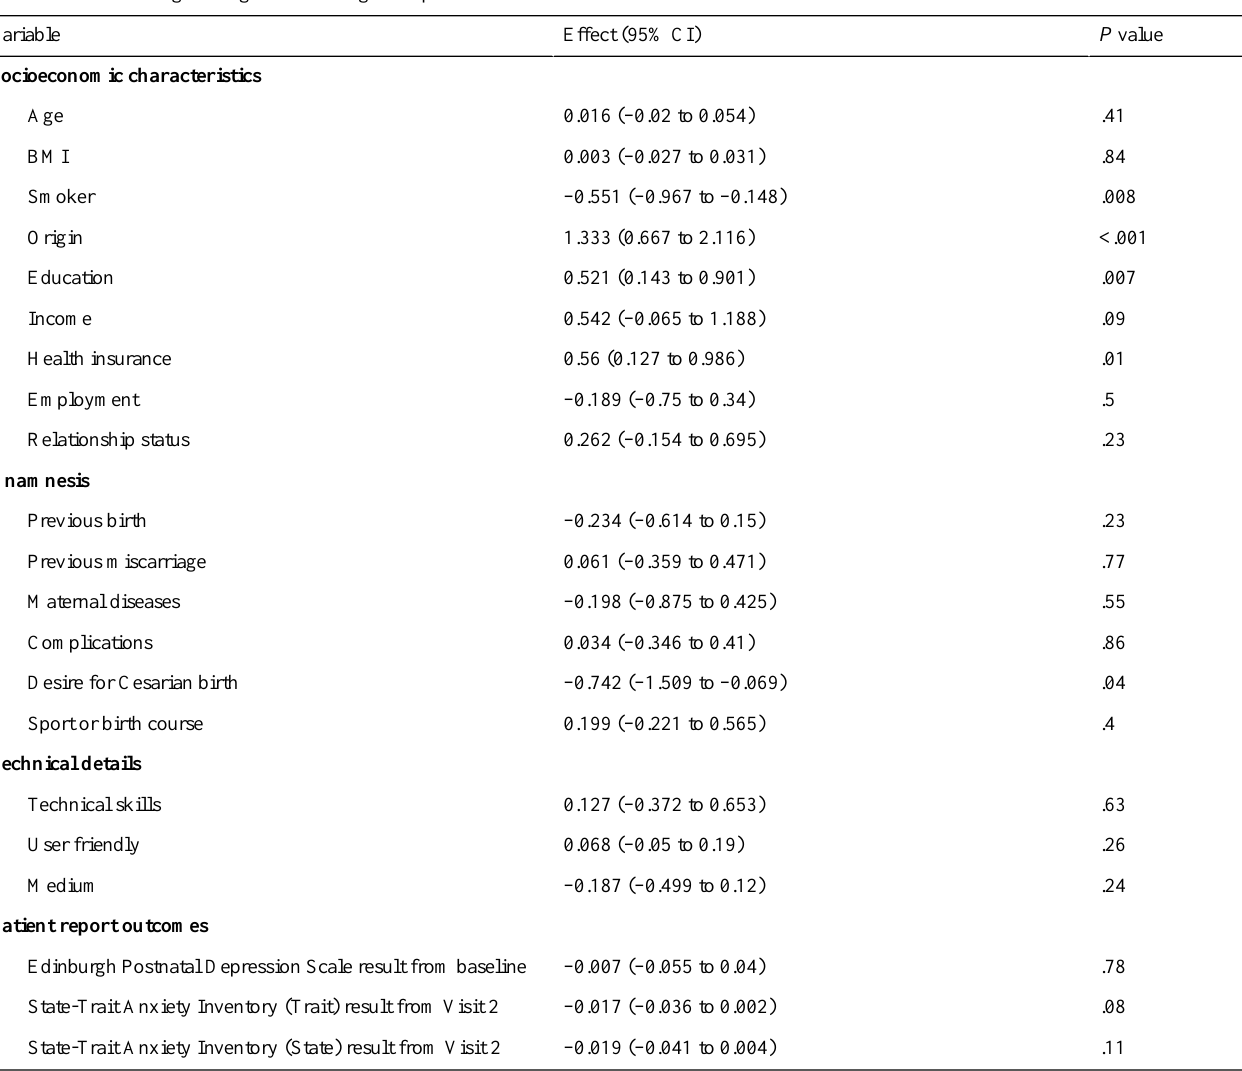
Table 4. Univariate logistic regression on high compliance.